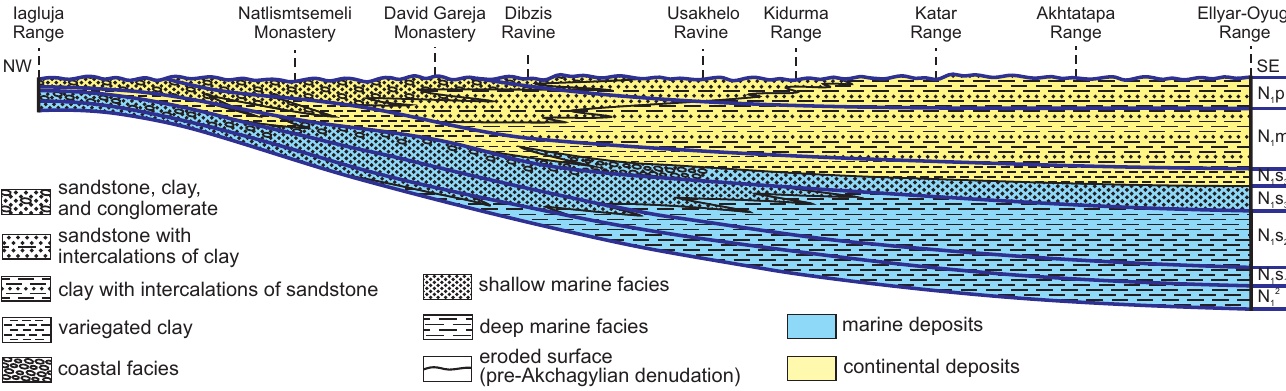
Fig. 2. The scheme of migration of the lithofacies of the Miocene deposits of South Kakheti (Middle Kura Basin), adapted from Buleishvili (1960). The Khersonian continental facies, variegated clay of the Eladri Formation, are the thickest in the south-western part of the area; the transition of this continental formation into marine deposits can be traced starting from the Ravine Dibzis; and the marine deposits are the thickest at the mountain Ellyar- Oyugi. Abbreviations: N 1 p, Pontian; N 1 m, Meotian; N 1 s 32 , upper Khersonian (upper part of the upper Sarmatian); N 1 s 31 , lower Khersonian (lower part of the upper Sarmatian); N 1 s 2 , Bessarabian (middle Sarmatian); N 1 s 1 , Volhynian (lower Sarmatian) ; N 12 , Tarkhanian, Chokrakian, Karaganian, Konkian (middle